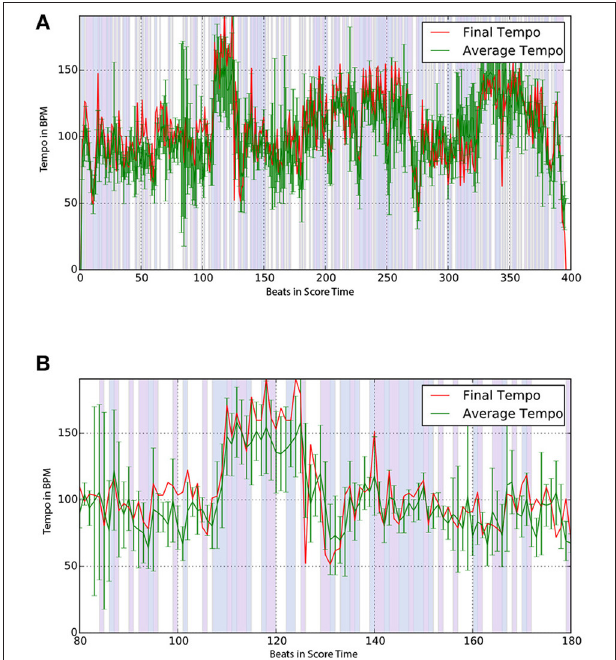
FIGURE 8 | Final (red) and average practice tempo (green) for an expert player (E-1). Backgrounds show same (decrease=light red, increase=light blue) and different (white) tempo changes. (A) Average and final tempo of full performance for an expert player (E-1). (B) Zoomed in version of (a) for time 80s to